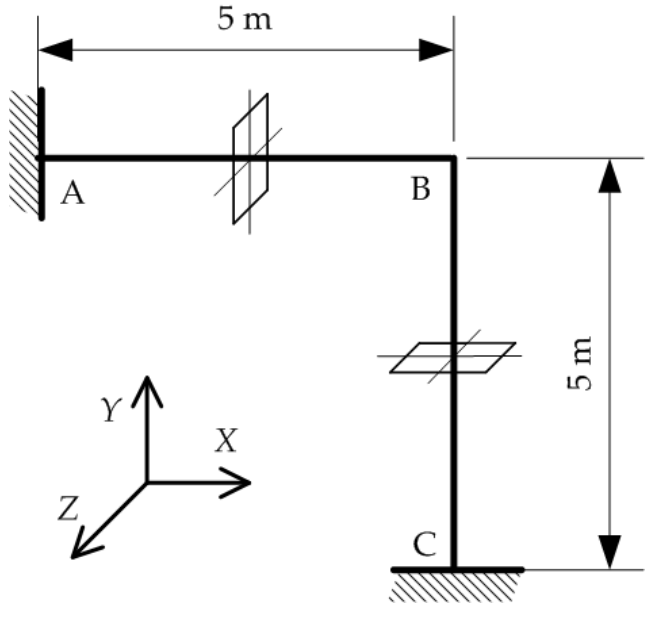
Figure 7. L-frame. Figure 7.